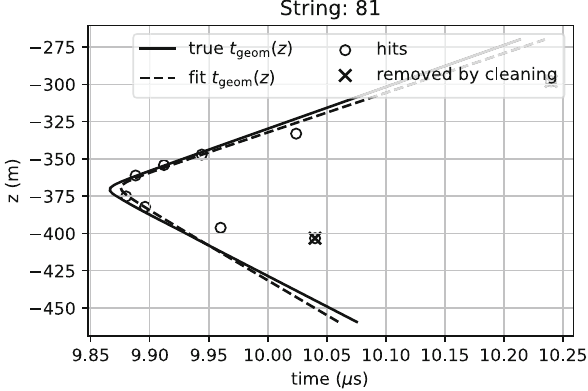
Fig. 3 Example of a ν CC μ event reconstructed with santa on a single string. Circles show each hit, where the z-coordinate is the position of the DOM and the time is the time of the first observed pulse in that